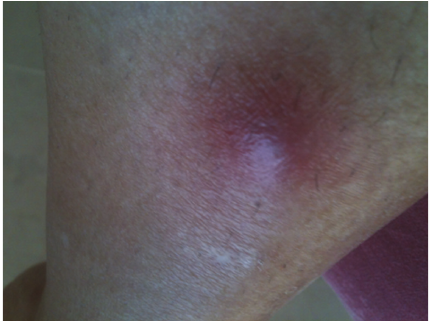
Figure 1: Initial lesion: erythematous nodule on right shin.